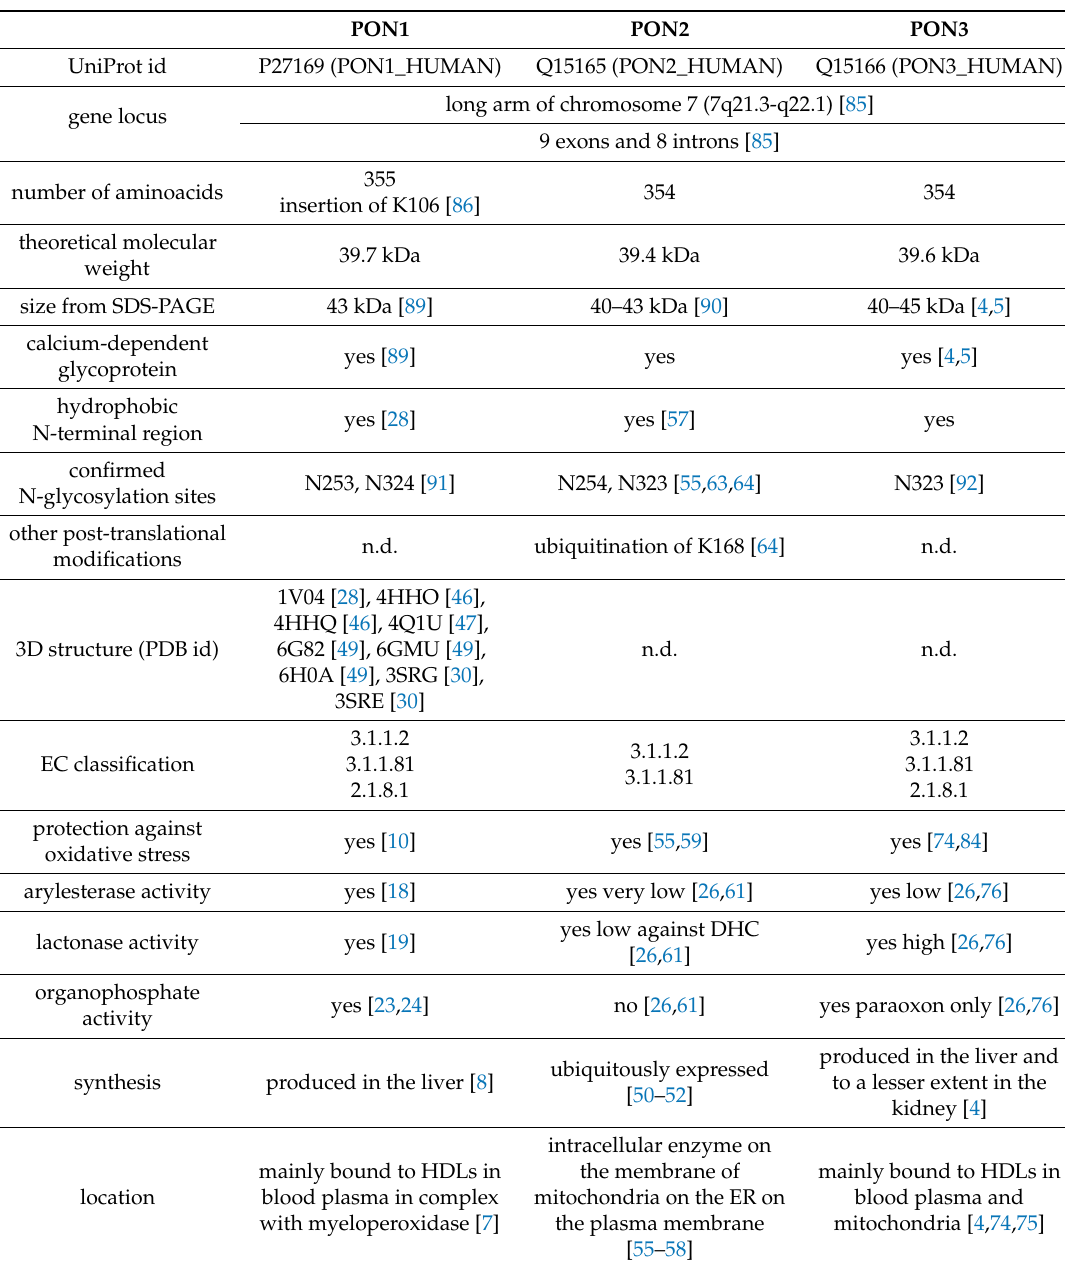
Table 2. A comparison of all three